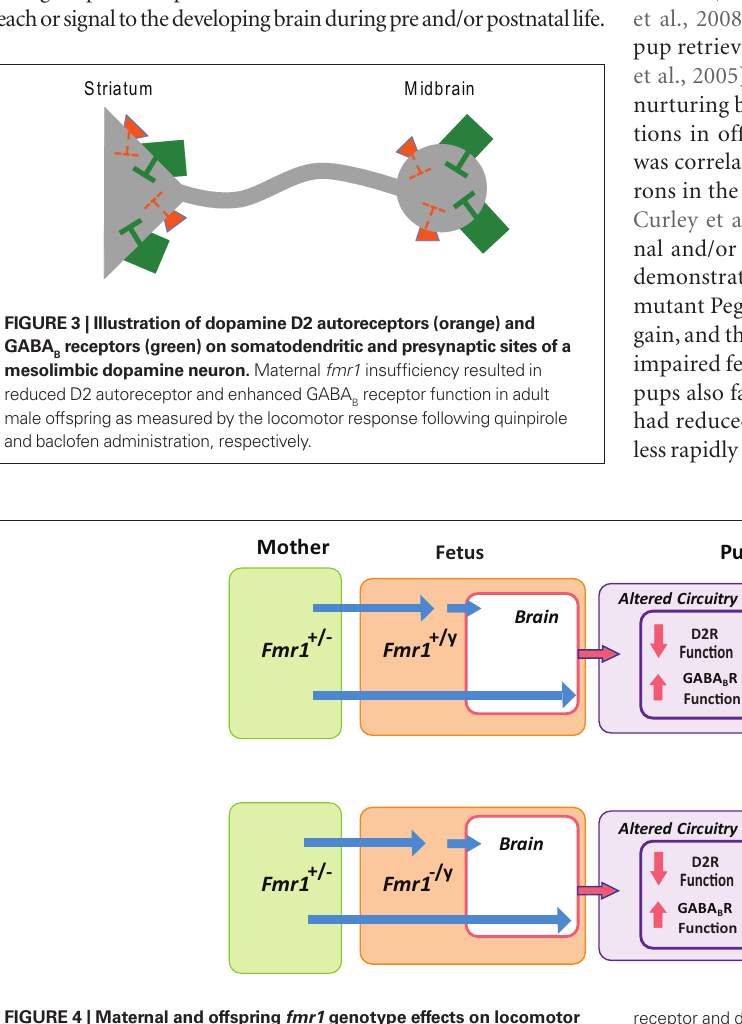
receptor and decreases D2 autoreceptor function and this effect is not further modified by the offspring’s own fmr1 expression suggesting that these neurochemical changes are specifically associated with the maternal deficit in B